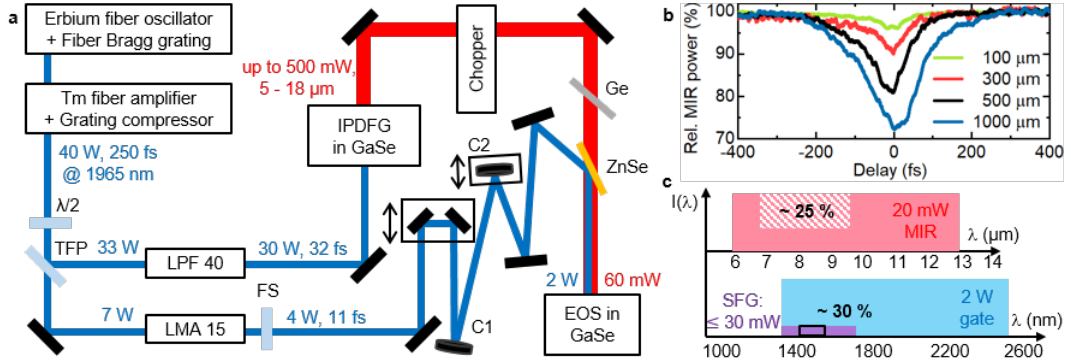
Fig. 1 (a) Experimental setup. TFP: Thin film polarizer, LPF: Large pitch fiber, LMA: Large mode area, C1, C2: concave mirrors. (b) Results of MIR depletion measurements for several EOS crystal thicknesses. (c) Sketch of the overall MIR photon detection